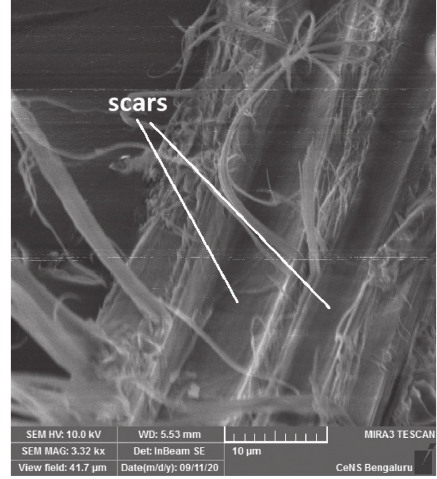
Figure 3: SEM of treated used jute epoxy composite